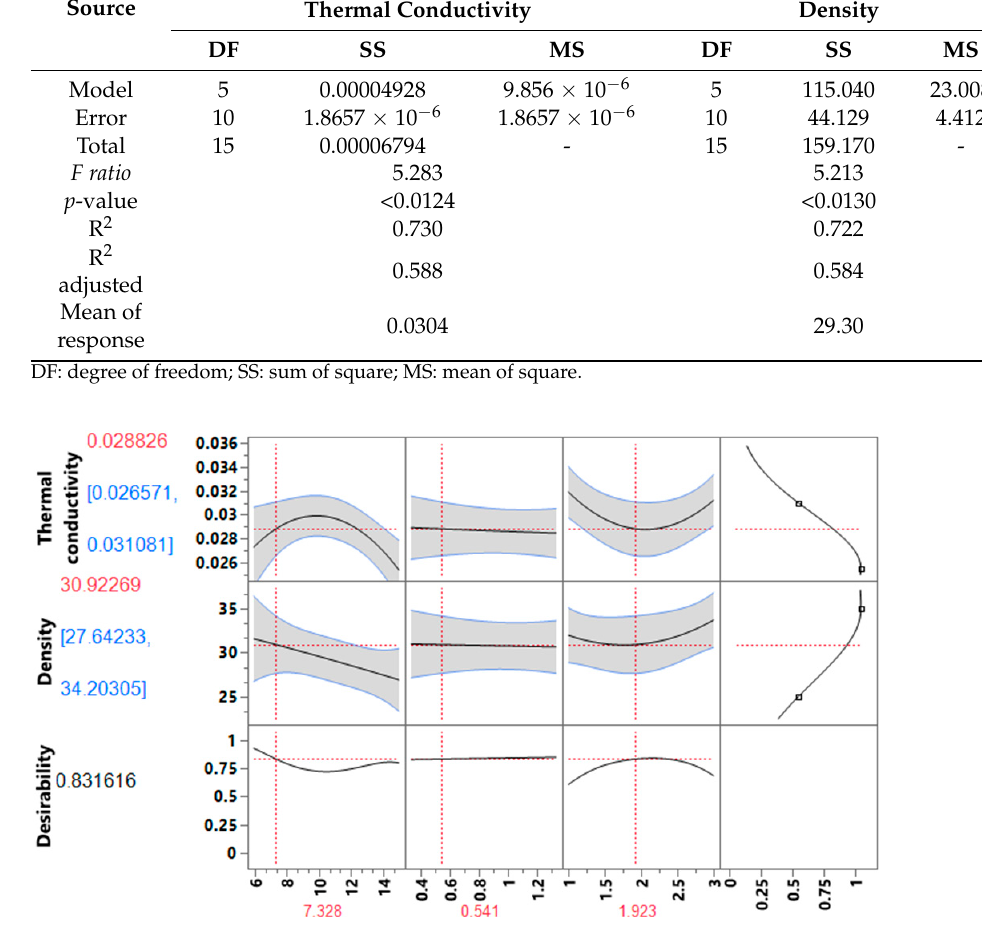
Table 4. Characteristics of the selected foams based on visual inspection.